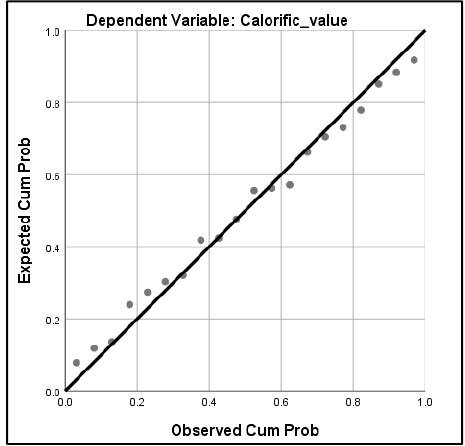
Figure 4. Normal P-P Plot of regression of the standardized residual of the calorific value (dependent variable). Table 2. Degree (Pearson correlation coefficients) and significance of correlations between the characteristics of the 20 pellet brands. In the second half of the table, the significant correlation values (<0.05) are depicted in bold.